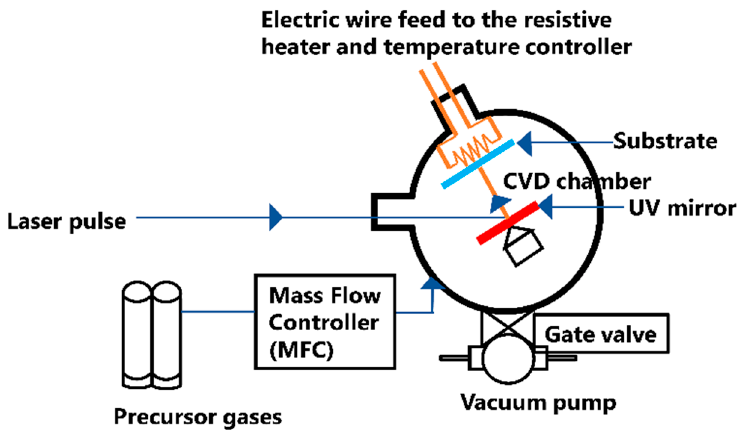
Figure 1. Schematic diagram of the deposition process in the